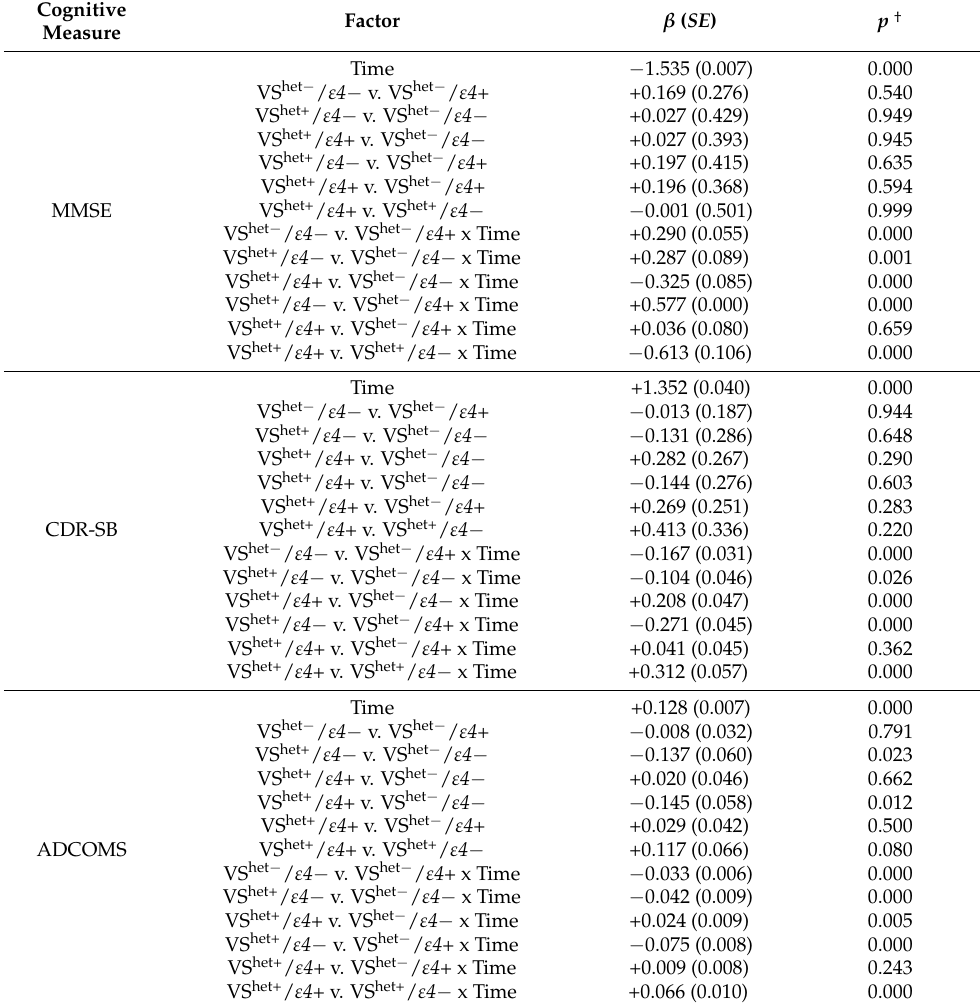
Table 3. Longitudinal LMM examining the predictive values of the KL -VS het and APOE ε 4 status on the yearly rate of cognitive decline in MMSE and CDR-SB scores in all participants ( N = 665) and ADCOMS in ADNI participants ( n = 178) with baseline age, sex, and years of education as covariates. Cognitive